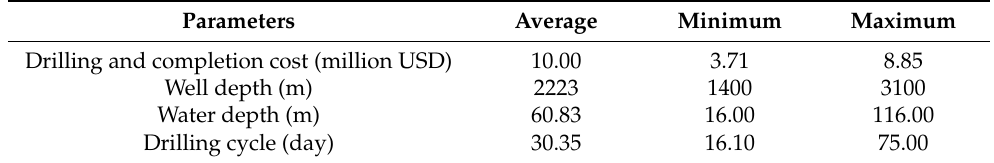
Table 1. Project parameters of six